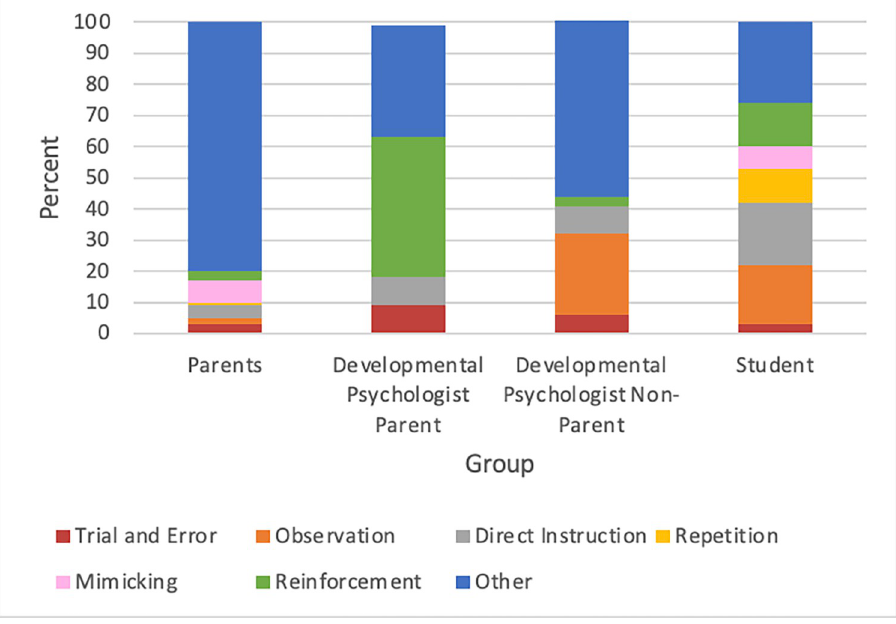
Fig 5. Participant responses on the mechanisms of development by group. Note : Statements not related to a mechanism were coded as Other.